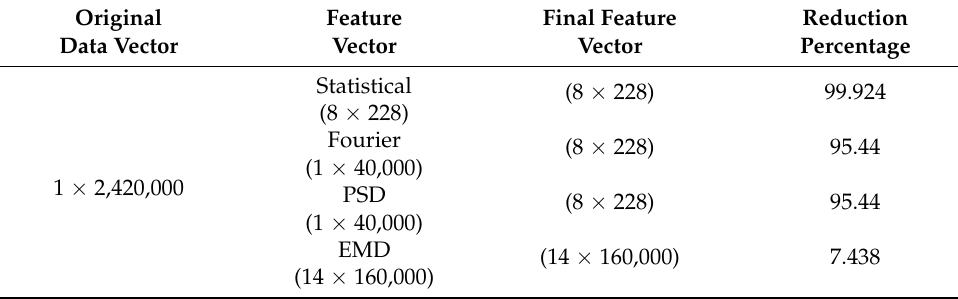
Table 2. Data dimensions and their reduction